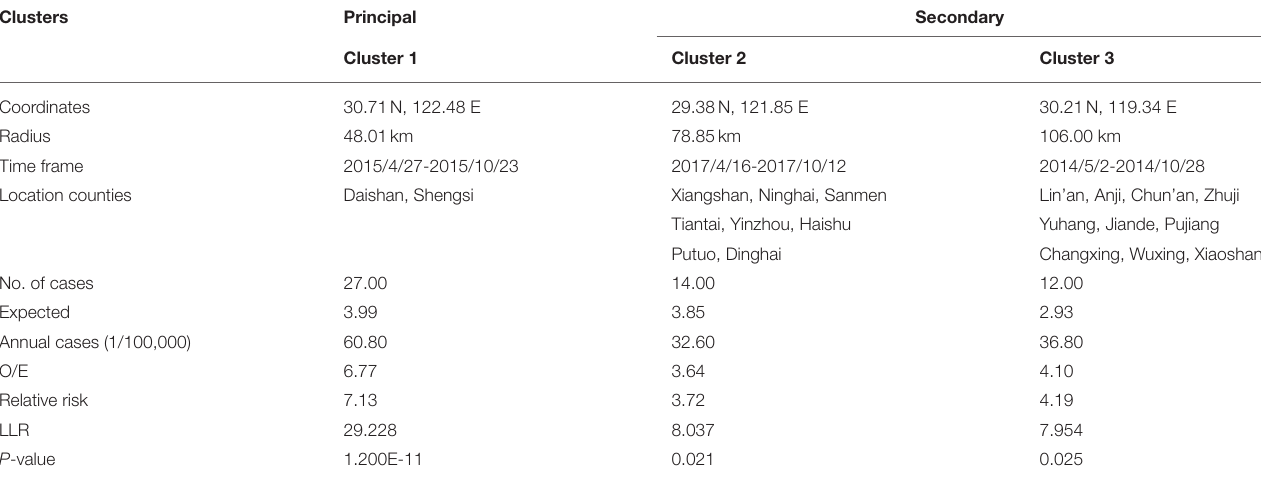
TABLE 2 | The results of spatial-temporal scanning.